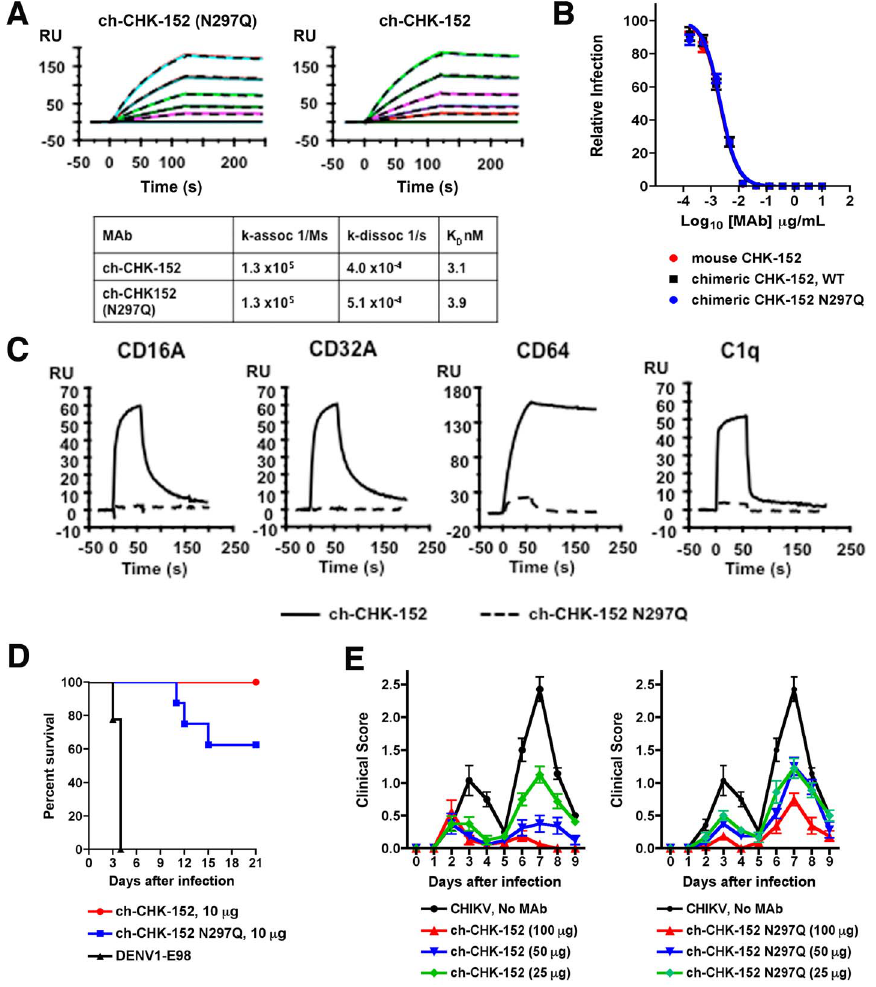
Figure 4. The effector functions of CHK-152 contribute to protection invivo . A . Comparison of binding of ch-CHK-152 and agylocsyl ch- CHK-152 N297Q to pE2-E1, as measured by surface plasmon resonance. A single representative sensogram is shown for each MAb. The experimental curves ( colored lines ) were fit using a 1:1 Langmuir analysis ( dashed lines ), after double referencing, to determine the kinetic parameters presented in the Table immediately below. B . Comparison of neutralizing activity of murine CHK-152, ch-CHK-152, and ch-CHK-152 N297Q, as measured by FRNT on Vero cells. C . Comparison of binding of ch-CHK-152 and ch-CHK-152 N297Q to Fc c R (CD16A, 500 nM; CD32A, 100 nM; and CD64, 100 nM) or C1q (50 nM), as measured by surface plasmon resonance. D . Comparison of pre-exposure protective activity of ch-CHK-152 and ch-CHK-152 N297Q. Ifnar 2 / 2 mice were administered via an i.p. injection 10 m g of ch-CHK-152 and ch-CHK-152 N297Q one day before infection with 10 FFU of CHIKV-LR via a s.c. route. Mice were monitored for survival for 21 days after infection. The survival curves were constructed from data of at least two independent experiments and the number of animals for each antibody ranged from 8 to 10 per group. ch-CHK-152 provided statistically greater protection than ch-CHK-152 N297Q ( P , 0.05). E . Five week-old WT C57BL/6 mice were infected with 100 PFU of CHIKV in the left rear footpad and either sham-treated, or treated with 100, 50, or 25 m g of ch-CHK-152 ( left panel ) or ch-CHK-152 N297Q ( right panel ) at 18 hours post infection. Mice were scored daily for virus-induced footpad swelling, where a score of 0=no swelling, 1=mild swelling where the top of the foot is slightly raised, 2=moderate swelling with the entire top of foot raised, and 3=severe swelling involving both the top and bottom of the foot. Scores are the mean values for 7 to 8 mice per treatment group and are representative of three independent experiments. Ch-CHK-152 mediated protection was significantly greater than ch-CHK-152 N297Q on days 7, 8, and 9 post infection for the 100 m g antibody dose, and at day 7 post infection for the 50 m g dose, as determined by the Kruskal-Wallace test with Bonferroni correction ( P , 0.05). No statistically significant differences between ch-CHK-152 and ch-CHK-152 N297Q were observed with the 25 m g dose. Of note, we observed a reproducible decrease in clinical score on day 5 in many animals. This reflects the biphasic pattern of swelling: during the first 3 to 4 days, swelling is due to edema, whereas after day 5, it is due to inflammatory cell infiltration into the foot and ankle. overlapping ( Fig. 6A and D ); however, CHK-102 and CHK-263 eight sequences from CHK-102 escape variants contained an escape variants remained sensitive to neutralization by CHK-152 L210P mutation in the E2 protein; the remaining two and CHK-166. Notably, selection with combinations of MAbs sequences had a G209E mutation in E2. For CHK-152 (e.g., CHK-102 + CHK-152) failed to produce escape variants resistant variants, all sequences (9 of 9) contained a D59N despite several independent attempts (data not shown). mutation in E2 and two contained a second A89E substitution in E2. For CHK-263, 3 of 4 escape variants had a K215E To identify the mutations that conferred resistance, we change in E2, whereas 1 of 4 had mutations in E2 at G209E. sequenced plaque-purified escape variants ( Table 2 , top ). Six of